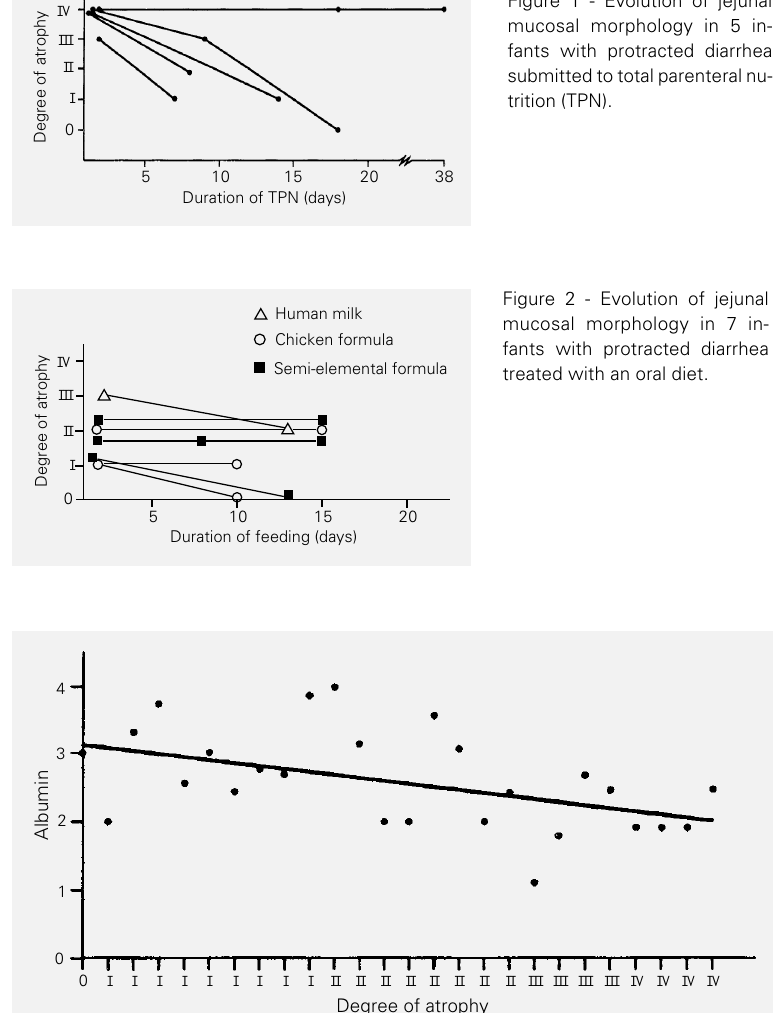
Figure 3 - Serum albumin level vs degree of jejunal mucosal atrophy in 26 infants with protracted diarrhea. r = -0.501,